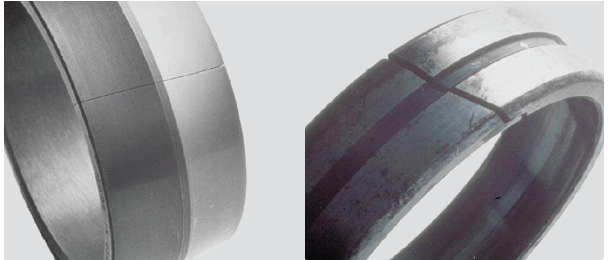
Figure 8. Fracture failure. Forced ( left ) and fatigue ( right ) [27]. Courtesy of SKF.